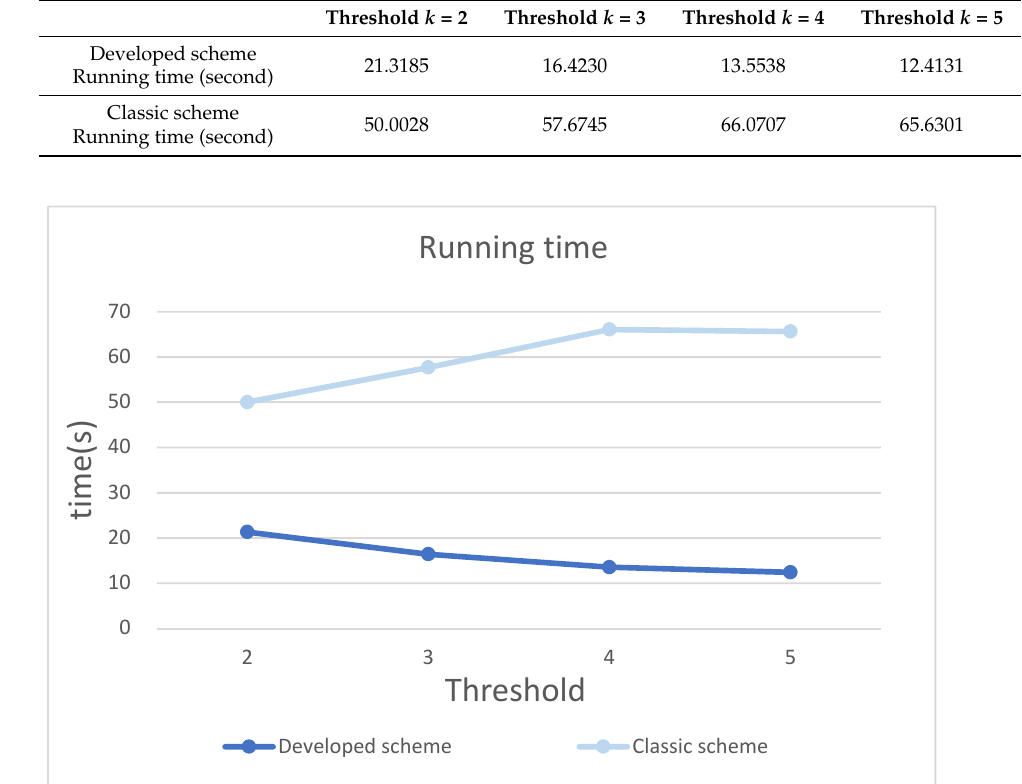
Table 1. Running time with different threshold in GF (2 8 ).